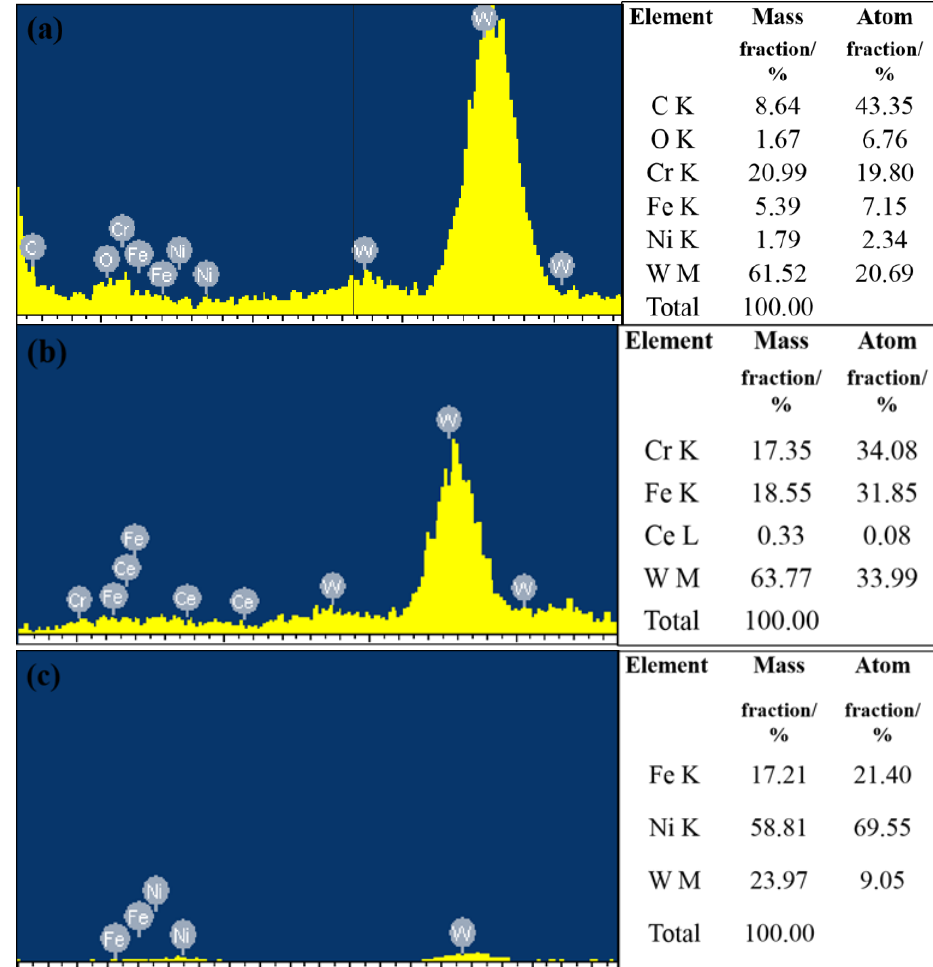
Figure 7. Energy dispersive spectroscopy (EDS) spectra of the different microstructural formations on the surface of the coating with 1.0% CeO 2 : ( a ) cell-like crystals, ( b ) dendrites, and ( c ) the bulk structure.